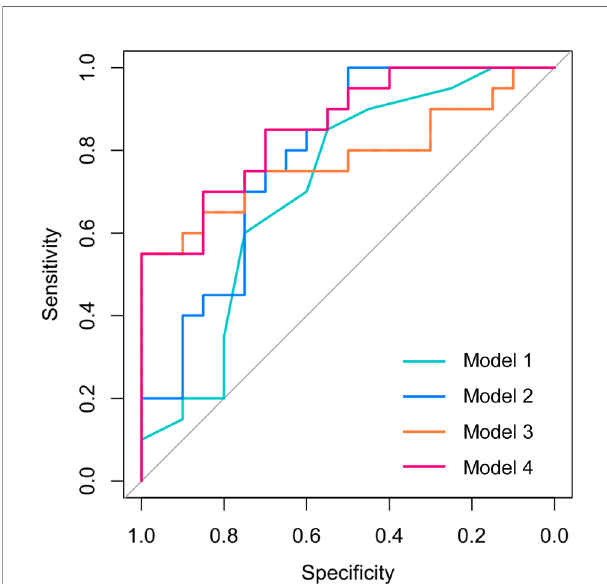
FIGURE 3 | Receiver operating characteristic (ROC) curves for the logistic regression model in the prediction of macrosomia in patients with GDM. Model 1 included maternal age. Model 2 included maternal age, fasting plasma glucose, and 2-h plasma glucose. Model 3 included GDF3 expression and AC006064.4 expression in peripheral blood exosomes. Model 4 included maternal age, fasting plasma glucose, 2-h plasma glucose, GDF3 expression, and AC006064.4 expression in peripheral blood exosomes.